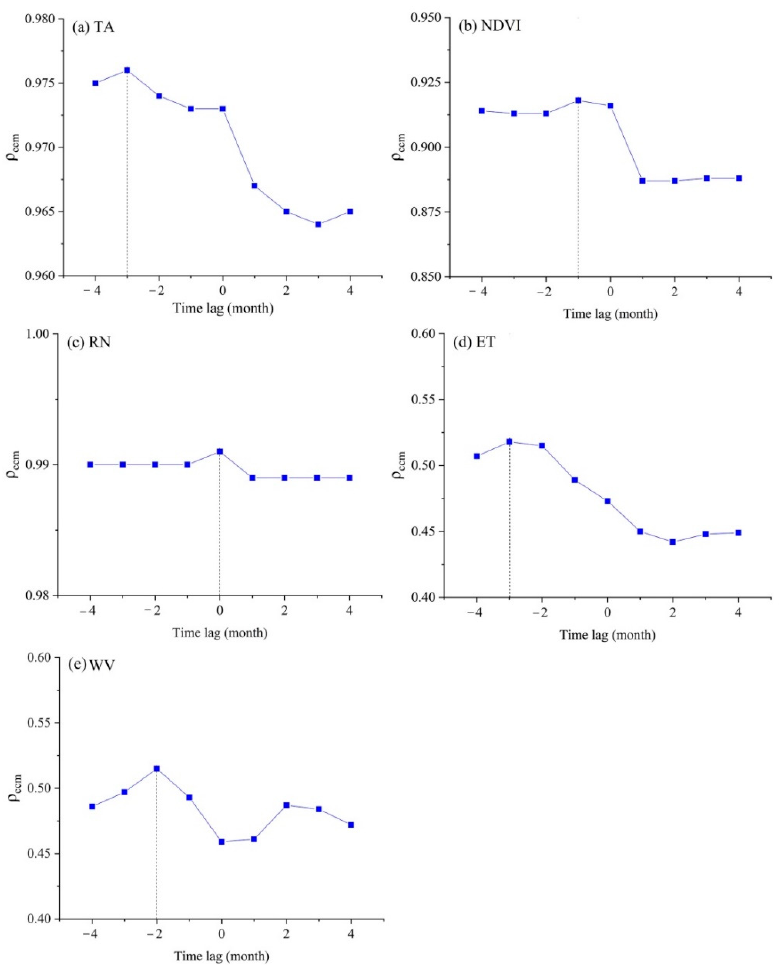
Figure 6. ECCM detection between LST and environmental factors for the pixel selected from PMC region ( a ) TA causing LST; ( b ) NDVI causing LST; ( c ) RN causing LST; ( d ) ET causing LST; ( e ) WV causing LST.